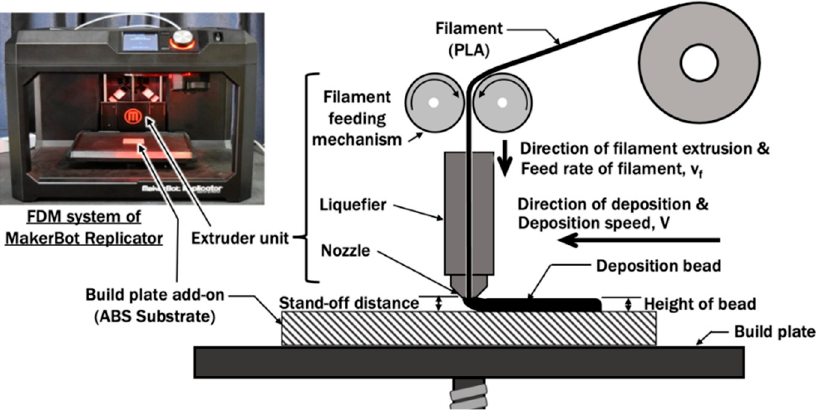
Figure 1. Schematic diagram of a material extrusion process.